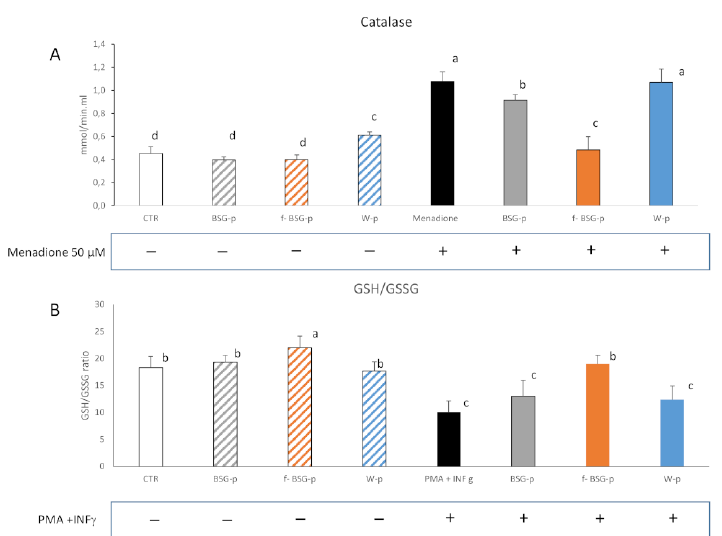
Figure 6. Catalase activity ( A ) and ratio of reduced and oxidized glutathione (GSH/GSSG) ( B ). Caco-2 cells were treated with wheat pasta (W-p), pasta containing native (BSG-p), and fermented (fBSG) brewers spent grain (BSG). To induce oxidative stress, Caco-2 cells were treated with a mixture of PMA INF- γ (8000 U/mL) and PMA (0.1 mg/mL). Data are the means ( ± SD) of three independent experiments analyzed in triplicate. Data were subjected to one-way ANOVA followed by Tukey’s procedure at p < 0.05. Bars with different superscript letters differ significantly ( p <